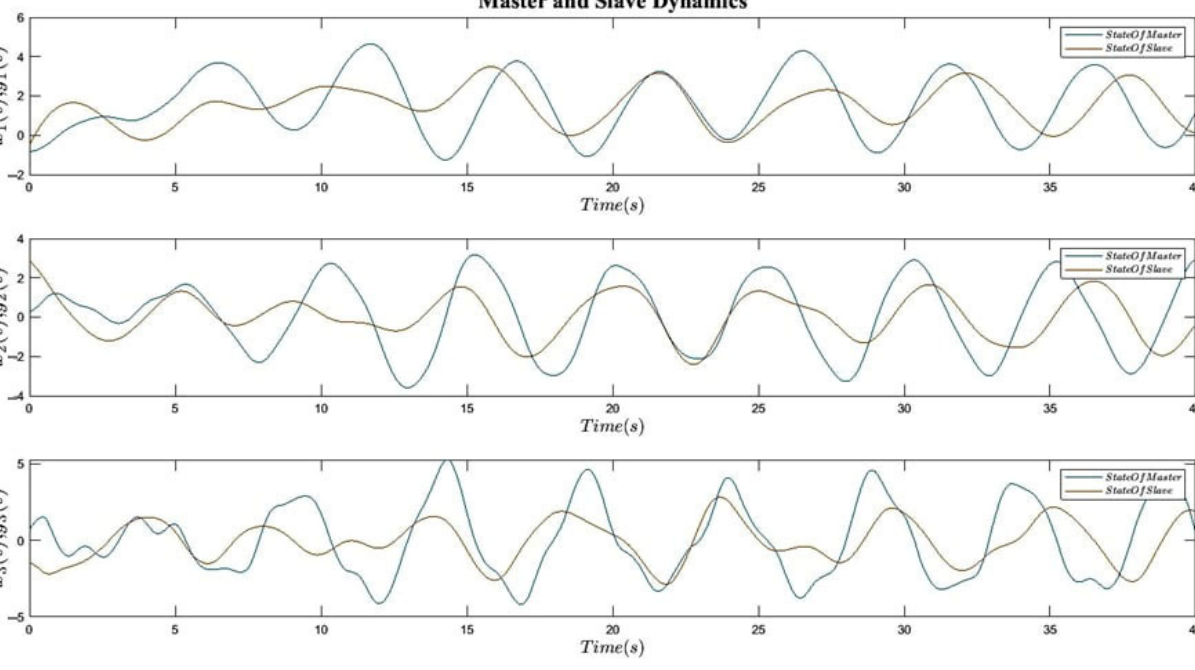
Figure 3. Synchronization of jerk systems using the proposed mechanism and applying the control signal at t = 5 s.